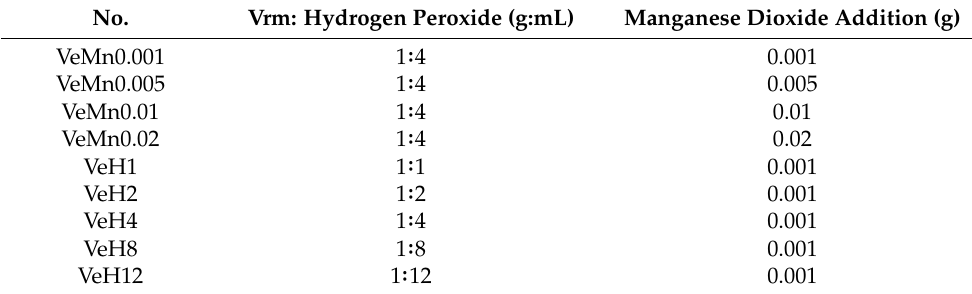
Table 2. Experimental scheme of expansion. No. VeMn0.001